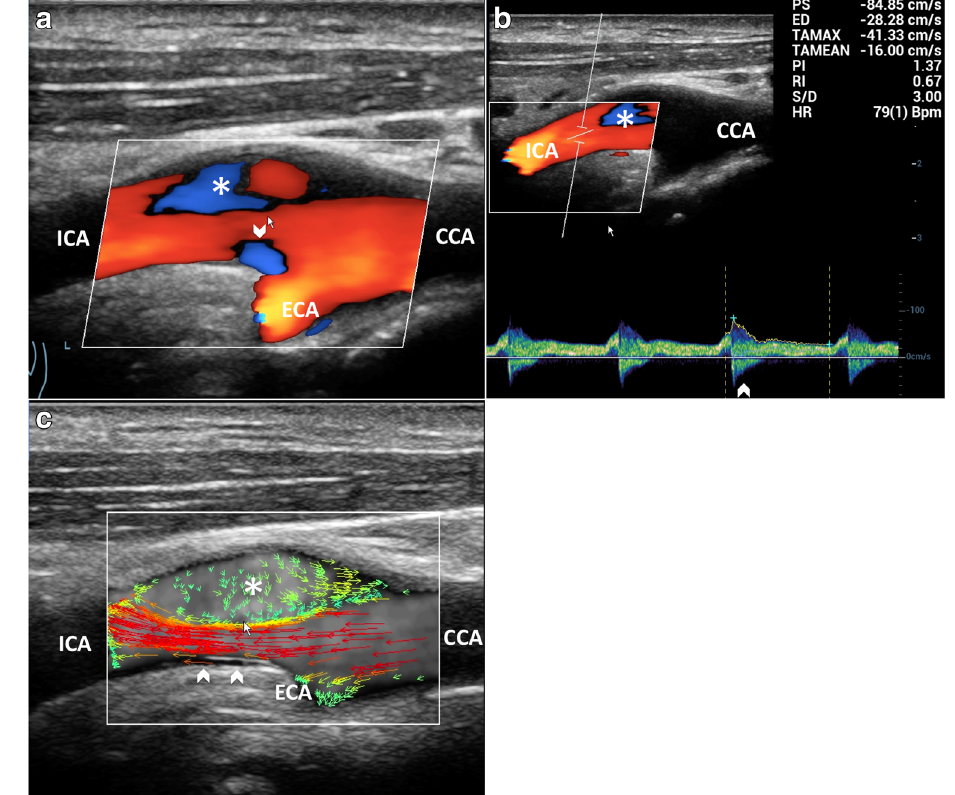
( arrowheads ) and a wide low flow vorticity